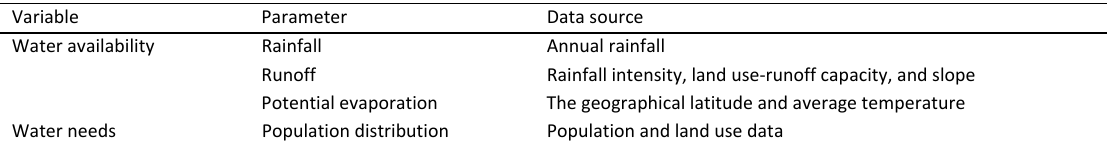
Fig. 1: Geographic location of the study area of Krasak watershed, in Indonesia (Mount Merapi is upstream and Kali Progo where is downstream of the watershed in Indonesia) Table 1: Parameters for water resources carrying capacity